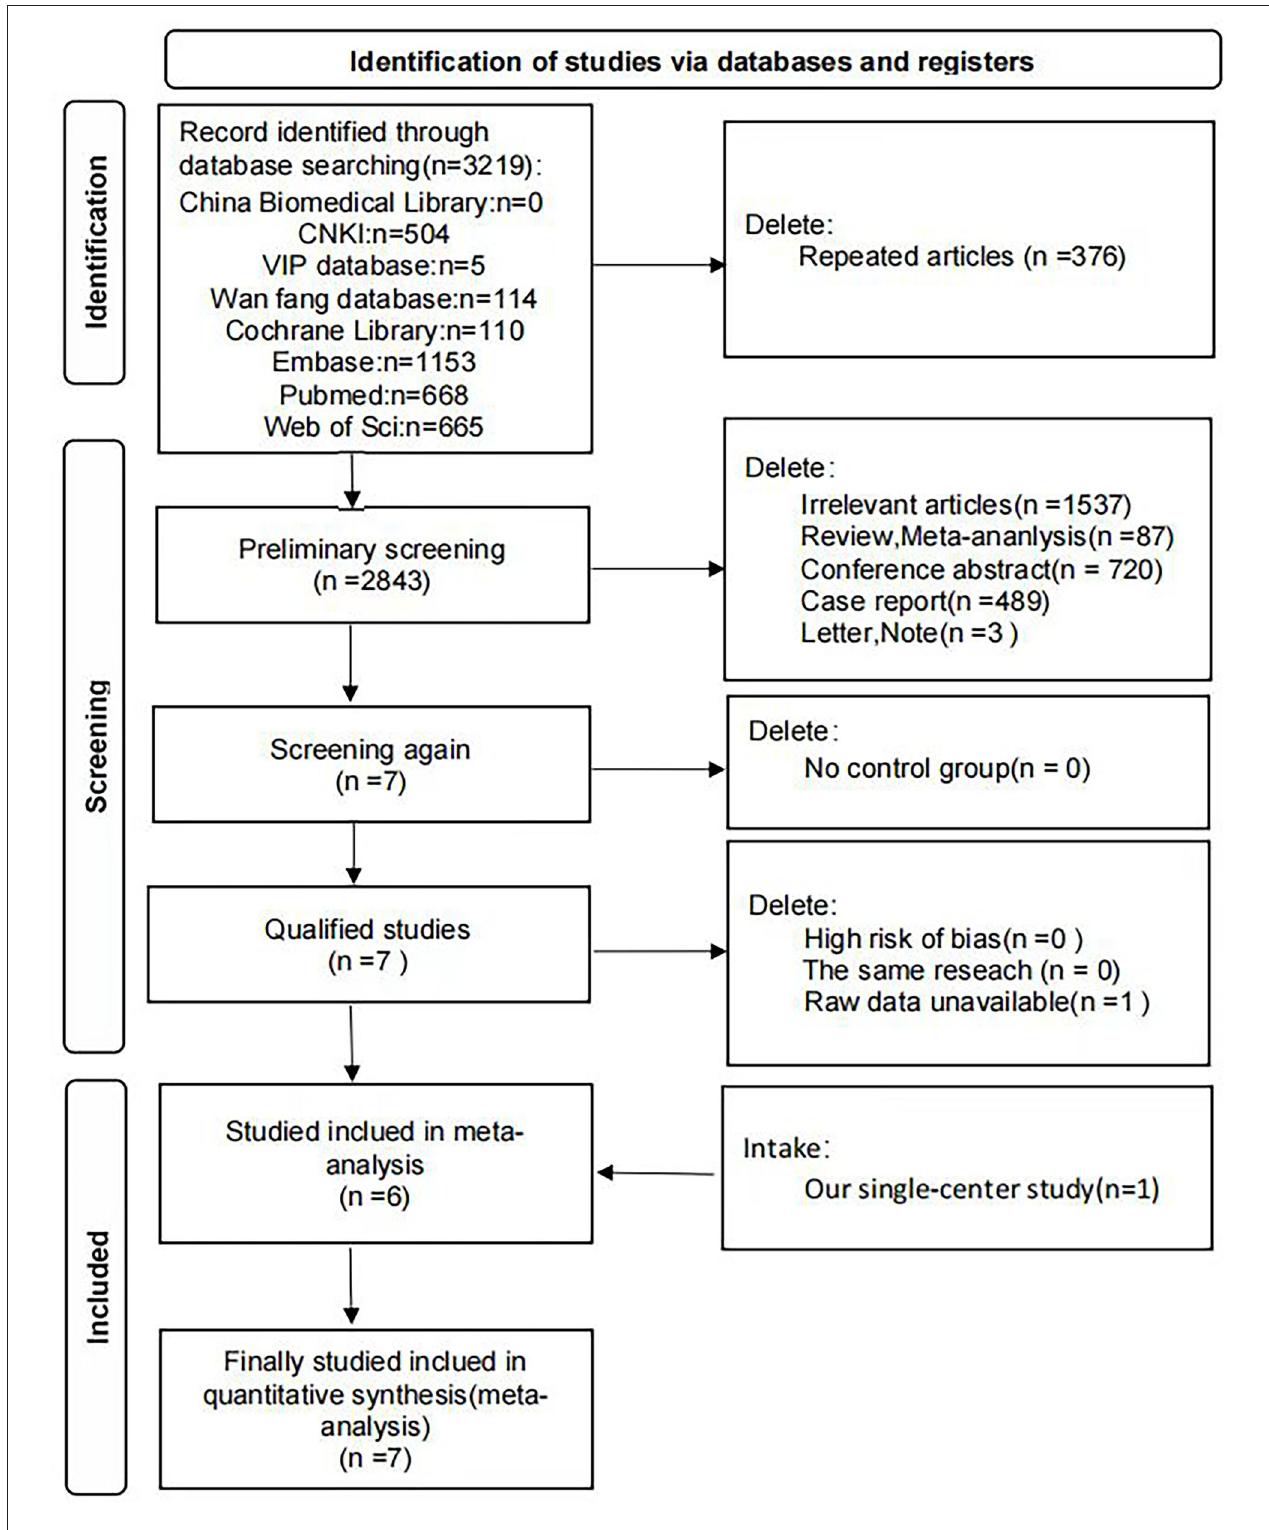
FIGURE 2 | Flow chart of document screening for meta-analysis. Flow chart presenting the process of study selection for meta-analysis. Seven literatures including our single-center study were included finally.